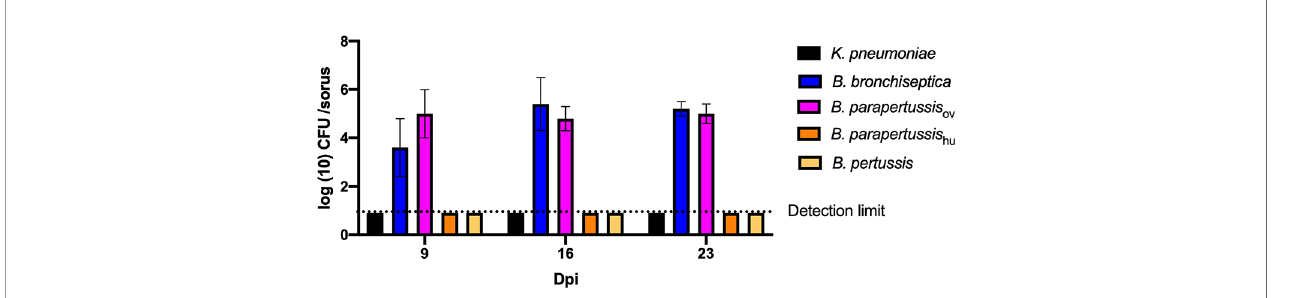
FIGURE 3 | Human-restricted Bordetella species, B. pertussis and B. parapertussis human strain, fail to colonize sori. The sori formed on the lawn of Bordetella species were collected at days 9, 16 and 23 post inoculation of amoebae. The bacteria that survived inside sori were enumerated by plating samples on BG agar plates. The colony number will be counted post 48 hours incubation in 37°C. Error bars show the standard error of